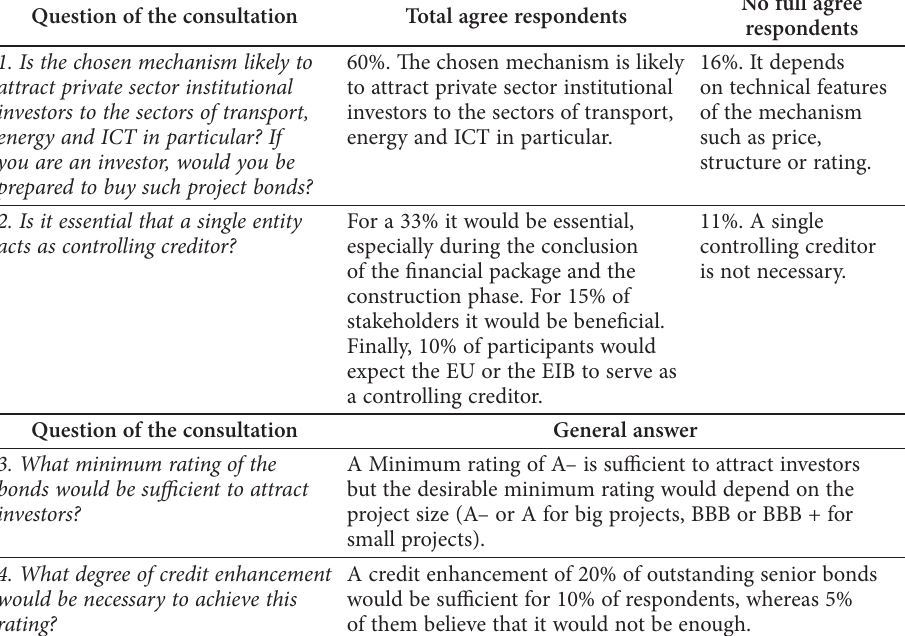
Table 2. Summary of the responses to the questions of the consultation regarding feasibility and man- agement of project bonds